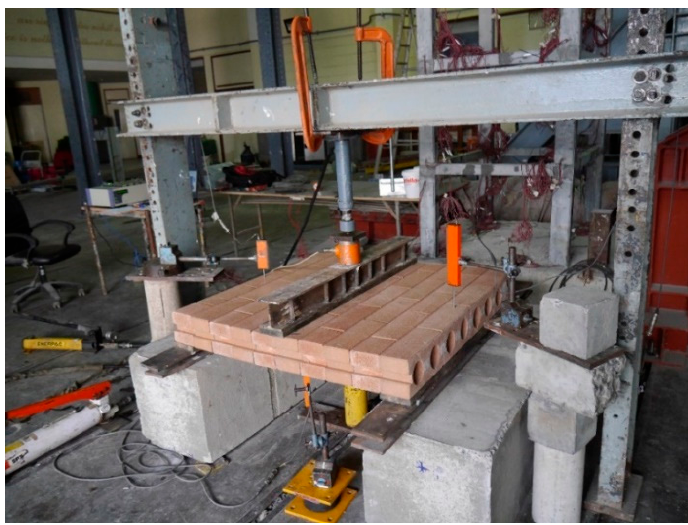
Figure 5. Typical loading setup.